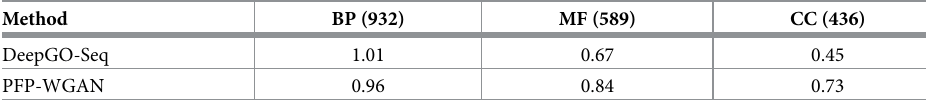
Table 2. Average prediction time in seconds for 1000 sequences.